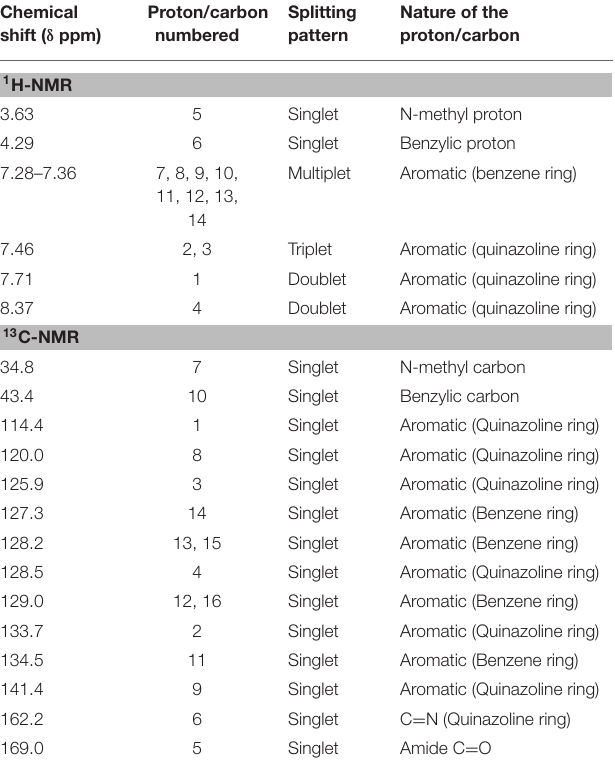
TABLE 3 | NMR ( 1 H-NMR and 13 C-NMR) spectral data of arborine compound.